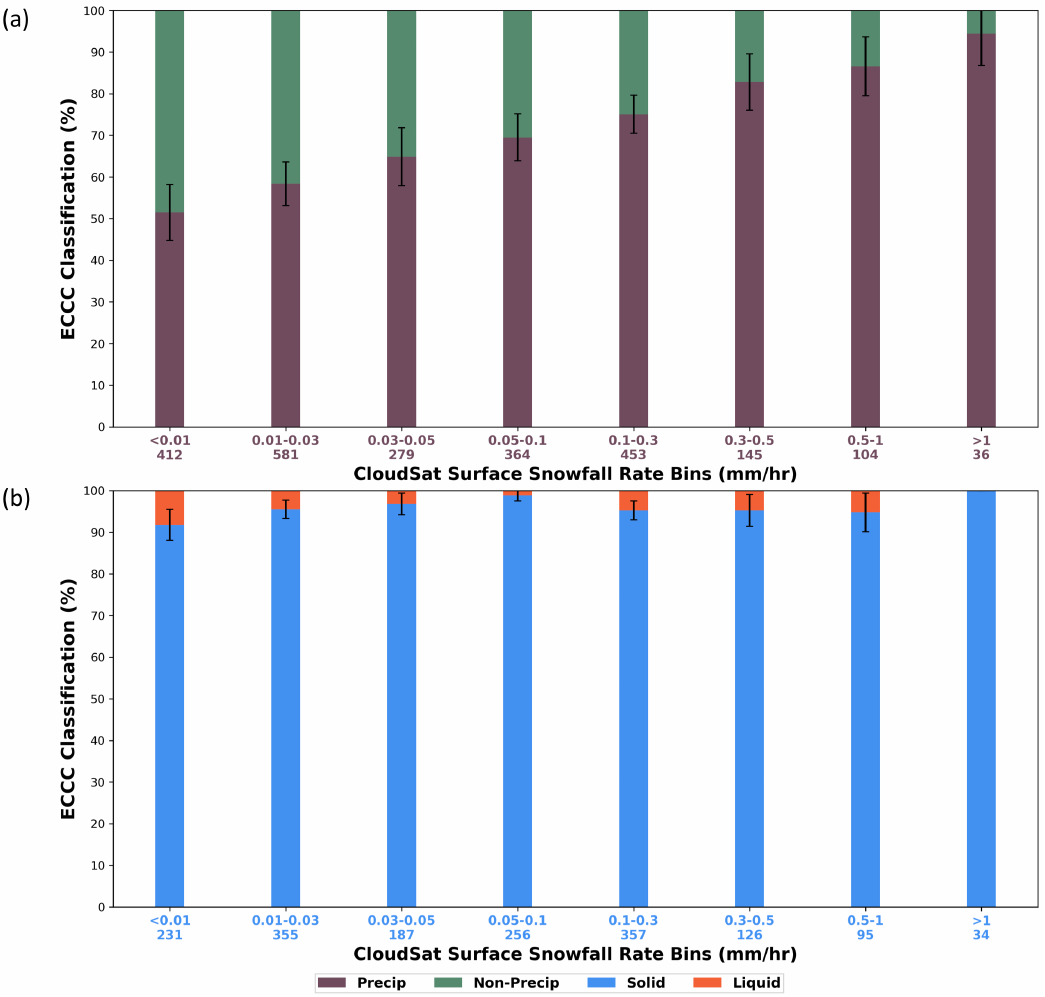
Figure 8. Percentages of CloudSat solid precipitation ( a ) occurrence and ( b ) phase that were reported in the ECCC ground data, binned using the CloudSat snowfall rate from 2C-SNOW-PROFILE. The number of coincident observations in each bin is shown under the x-axis below the bin intensity. The error bars represent 95% confidence intervals on each estimate, assuming that the samples are